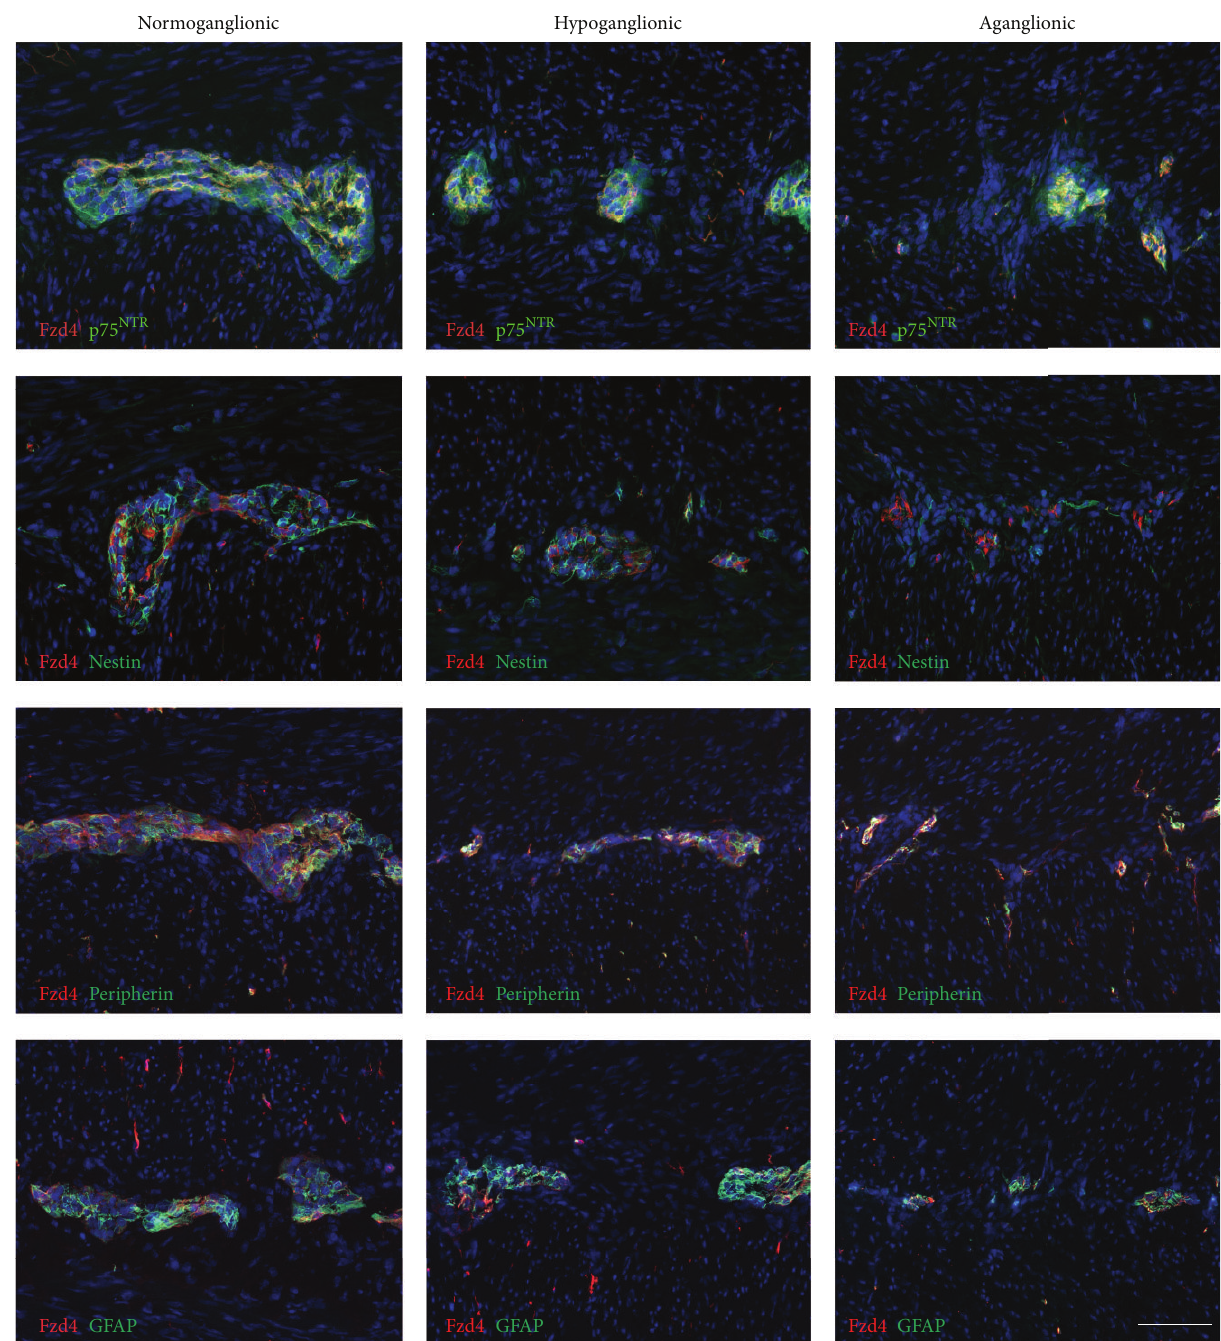
Figure 8: Coimmunostaining processes reveal the parallel decrease of frizzled-4 with other neural markers in Hirschsprung’s disease. Immunofluorescence for frizzled-4 (Fzd4, red) in combination with p 75 NTR , nestin, peripherin, and GFAP (green) on cryostat sections from large intestine diagnosed with Hirschsprung’s disease (sample number 10); cell nuclei were visualized with DAPI (blue). Fluorescence views were taken from normoganglionic, hypoglanglionic, and aganglionic area, respectively; scale bar: 100 𝜇